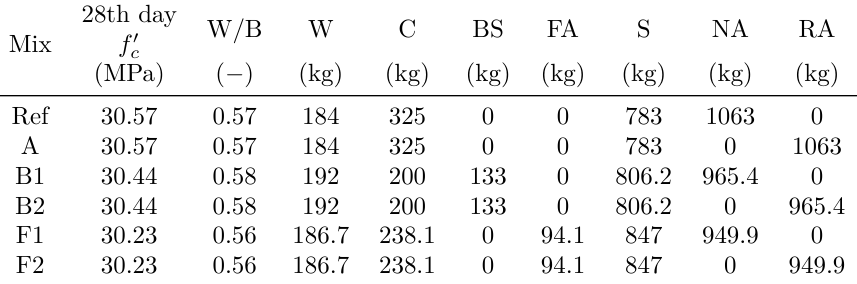
Table 6. Concrete mix proportions per m 3